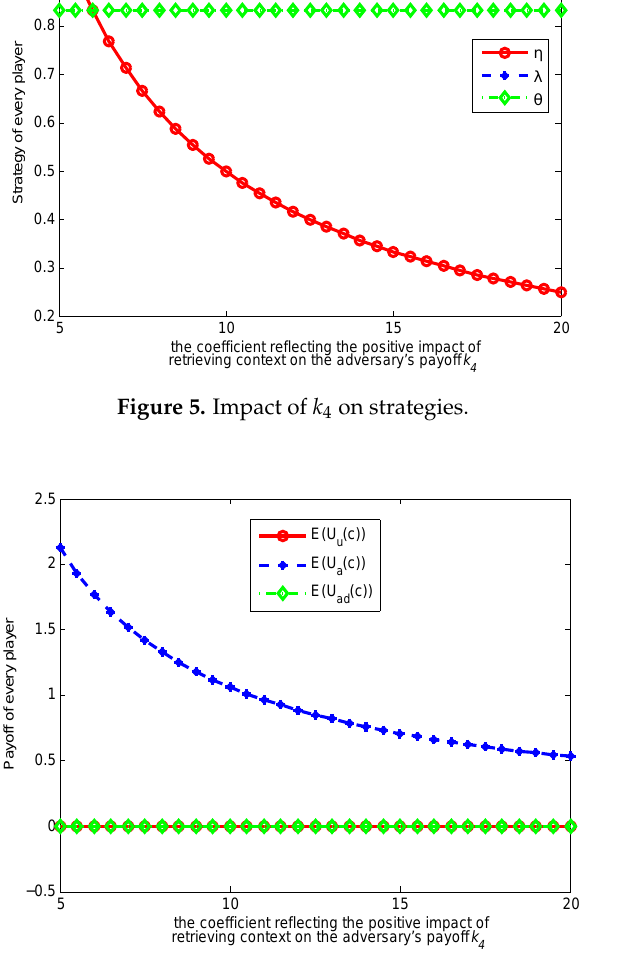
Figure 6. Impact of k 4 on